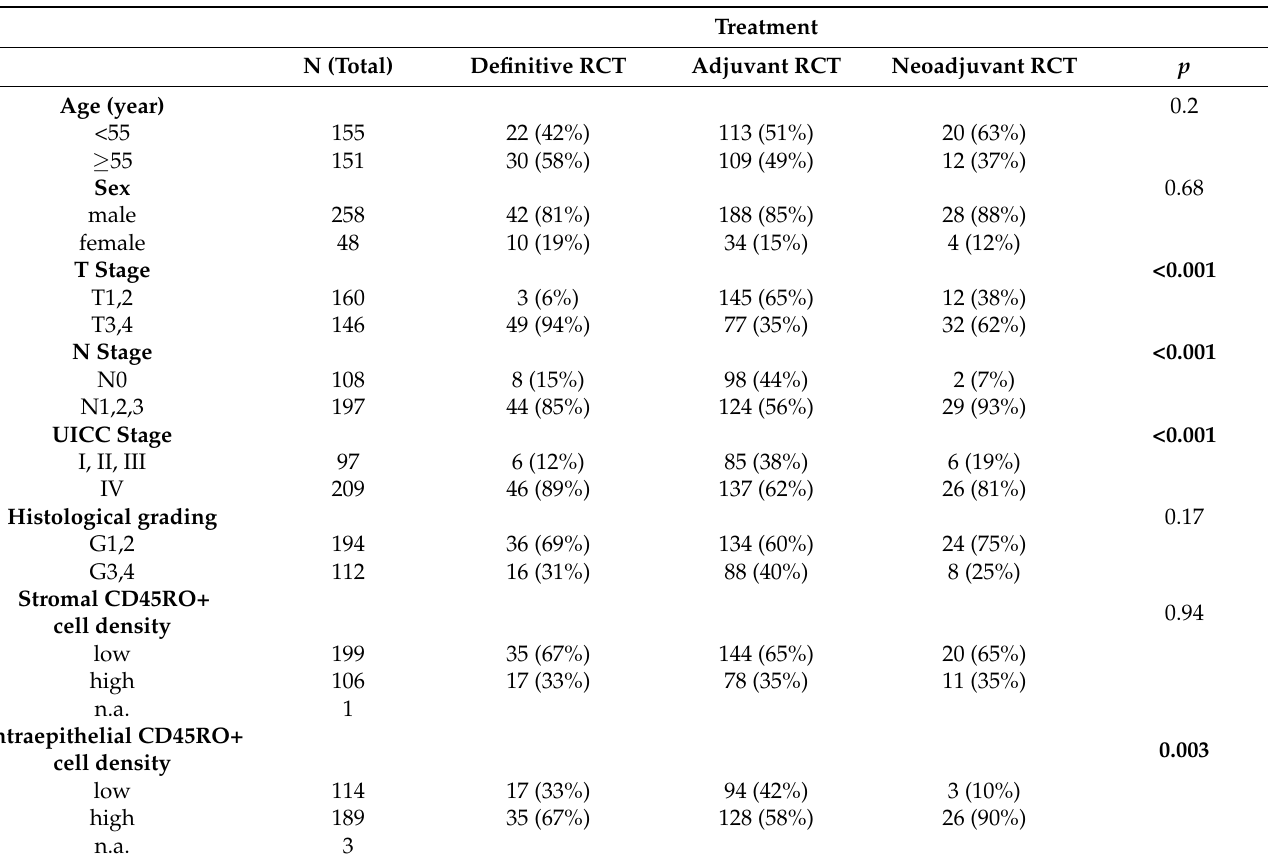
Table 3. Distribution of clinical characteristics and CD45RO+ cell density according to treatment